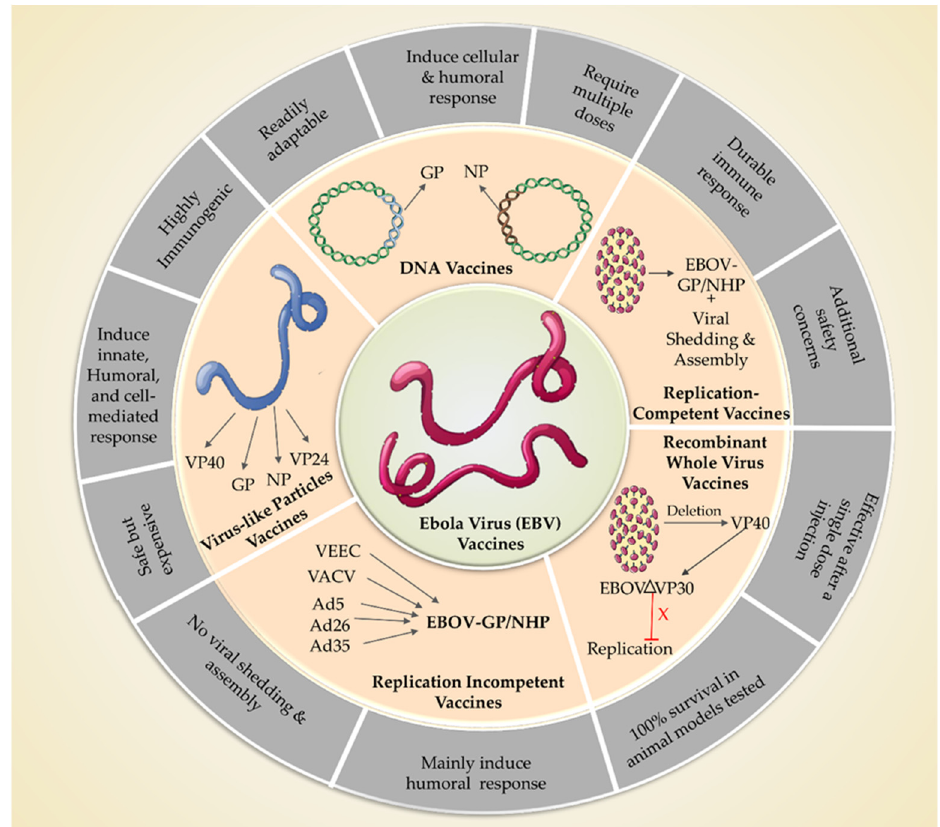
Figure 2. Current vaccination platforms and strategies available for EVD. Table 2. Vaccines against Ebola that are currently approved and under development.